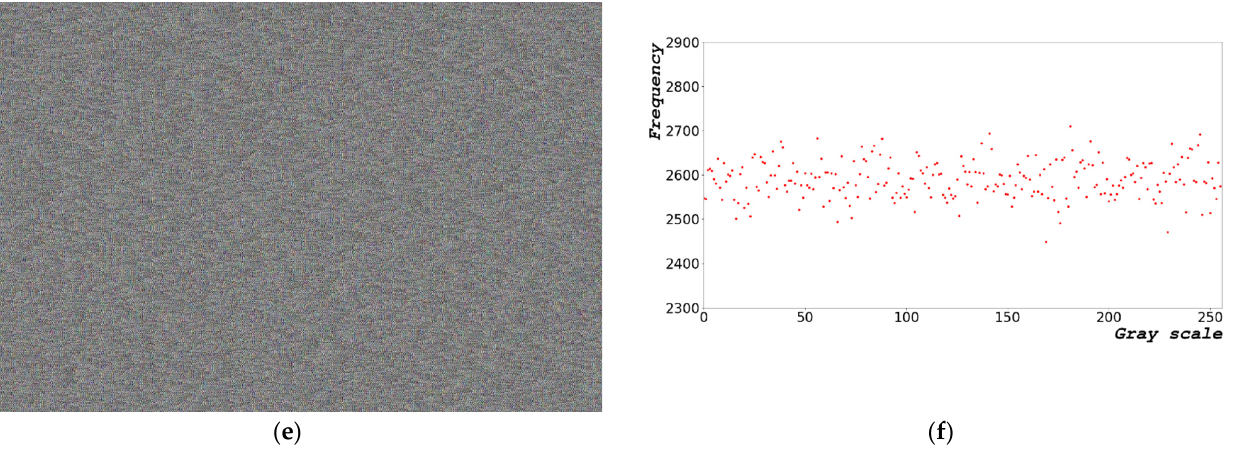
Figure 3. Random-bit generation results based on time: ( a ) 1000 × 663 random-bit visualization image; ( b ) 0–255, 8-bit entropy generation distribution diagram at dt = 0 μ s; ( c ) 1000 × 663 random-bit visualization image; ( d ) 0–255, 8-bit entropy generation distribution diagram at dt = 1.0 μ s; ( e ) 1000 × 663 random-bit visualization image; and ( f ) 0–255, 8-bit entropy generation distribution diagram at dt = 5.0 μ s.